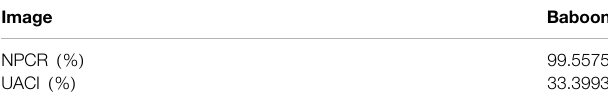
TABLE 5 | NPCR and UACI detection results of two encrypted images.